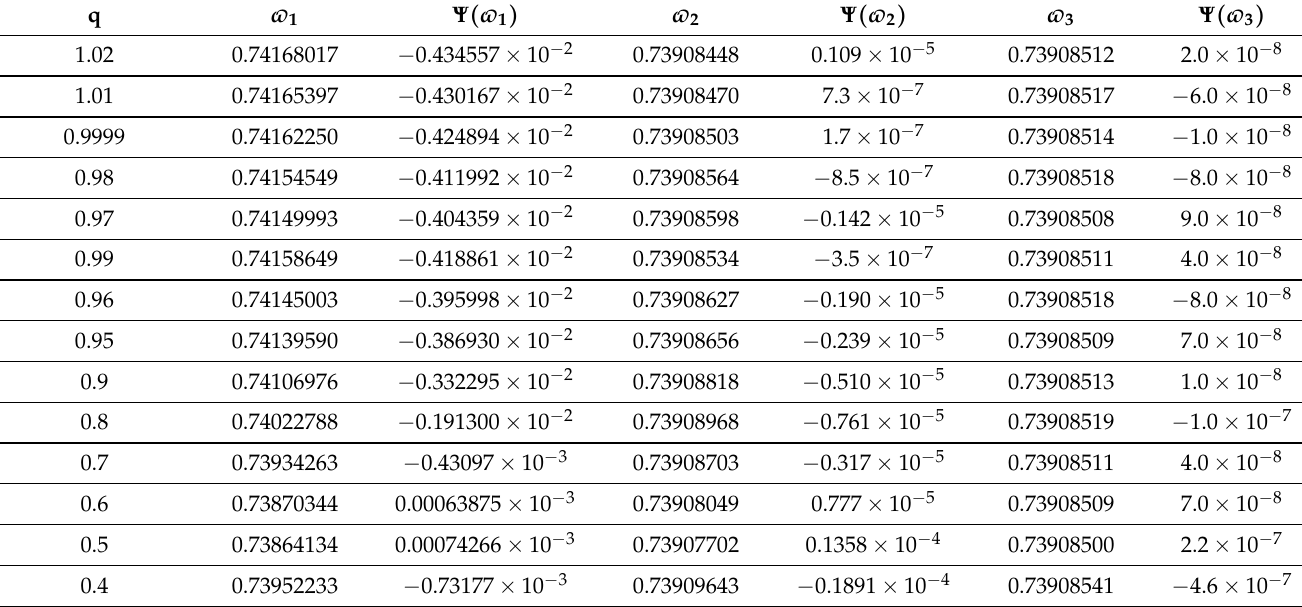
Table 3. Calculation of (cid:118) i and Ψ ( (cid:118) i ) for i = 1,2,3 and different values of q by using